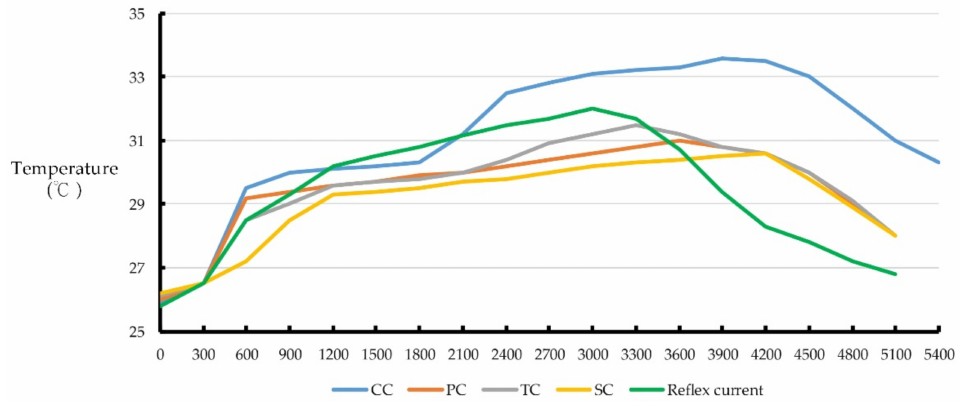
Figure 12. Temperature-increase curves of five charging methods.